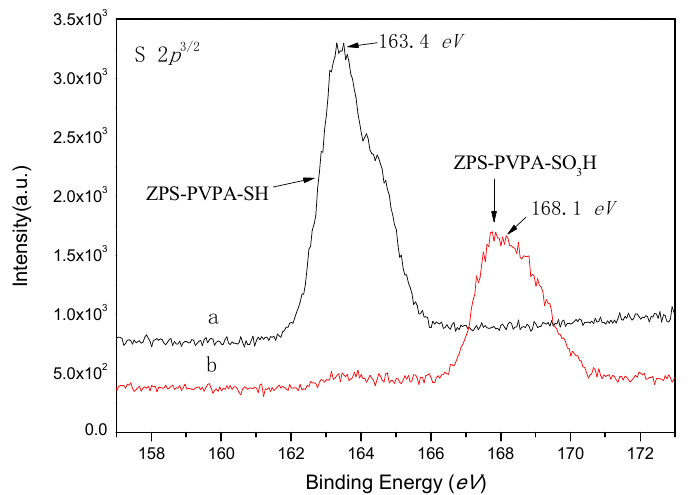
Figure 3. XPS of S 2p3 / 2 peaks of ( a ) ZPS–PVPA–SH and ( b ) ZPS–PVPA–SO 3 H.